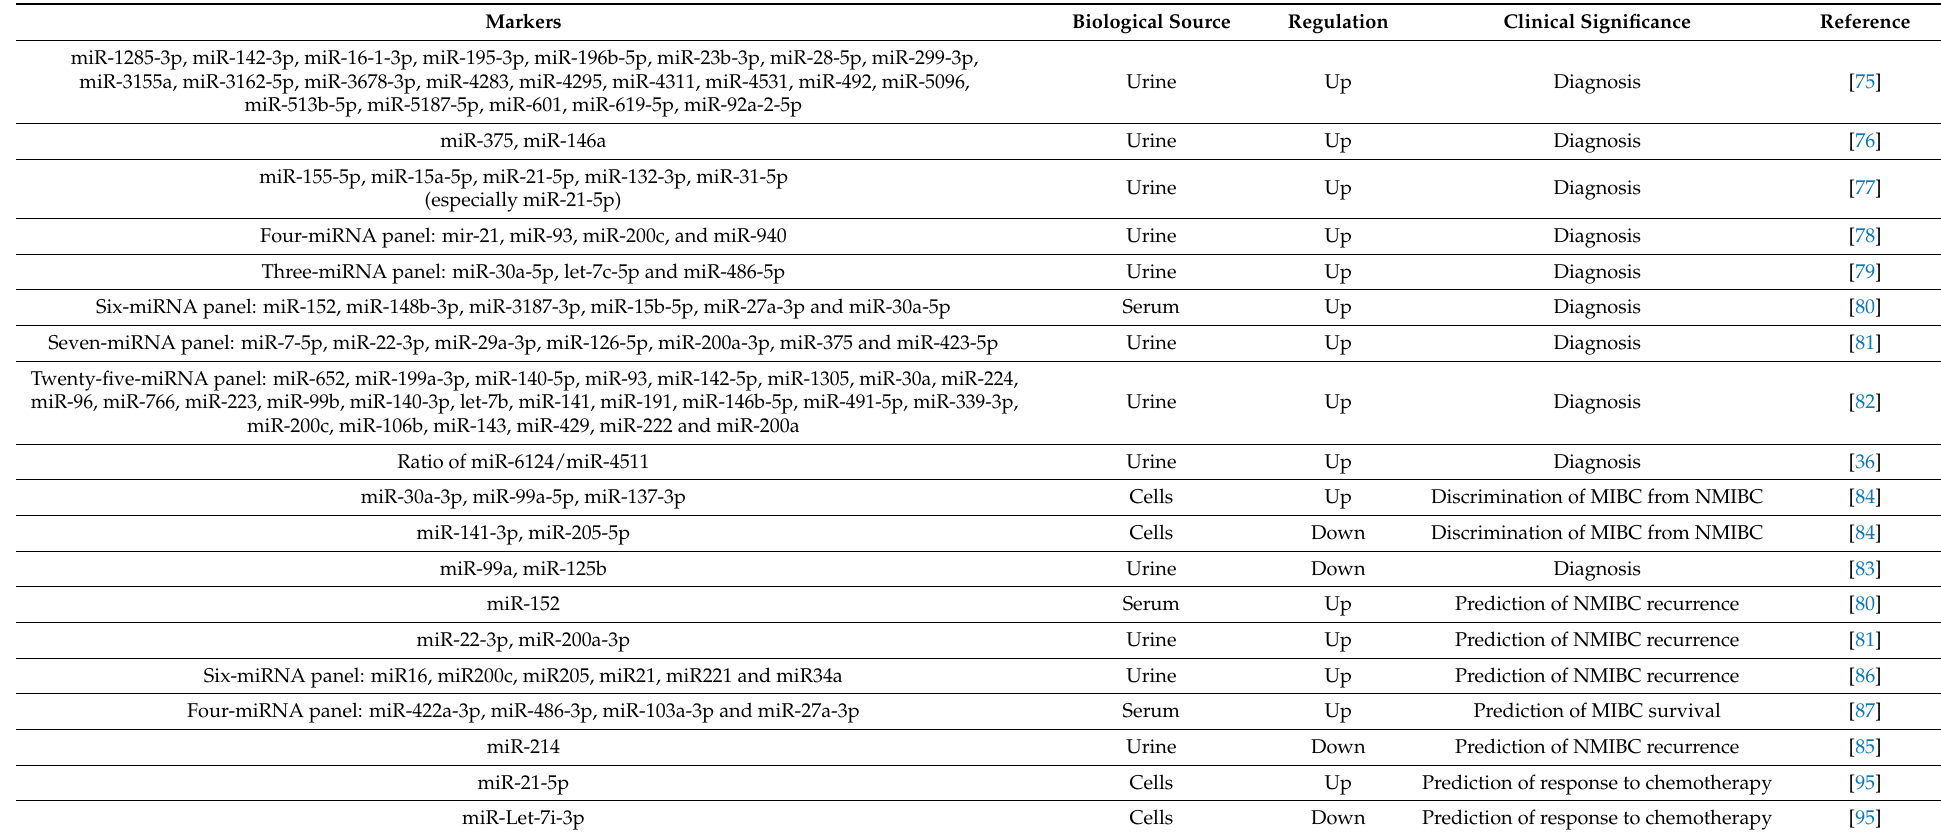
Table 2. List of exomiRs identified in